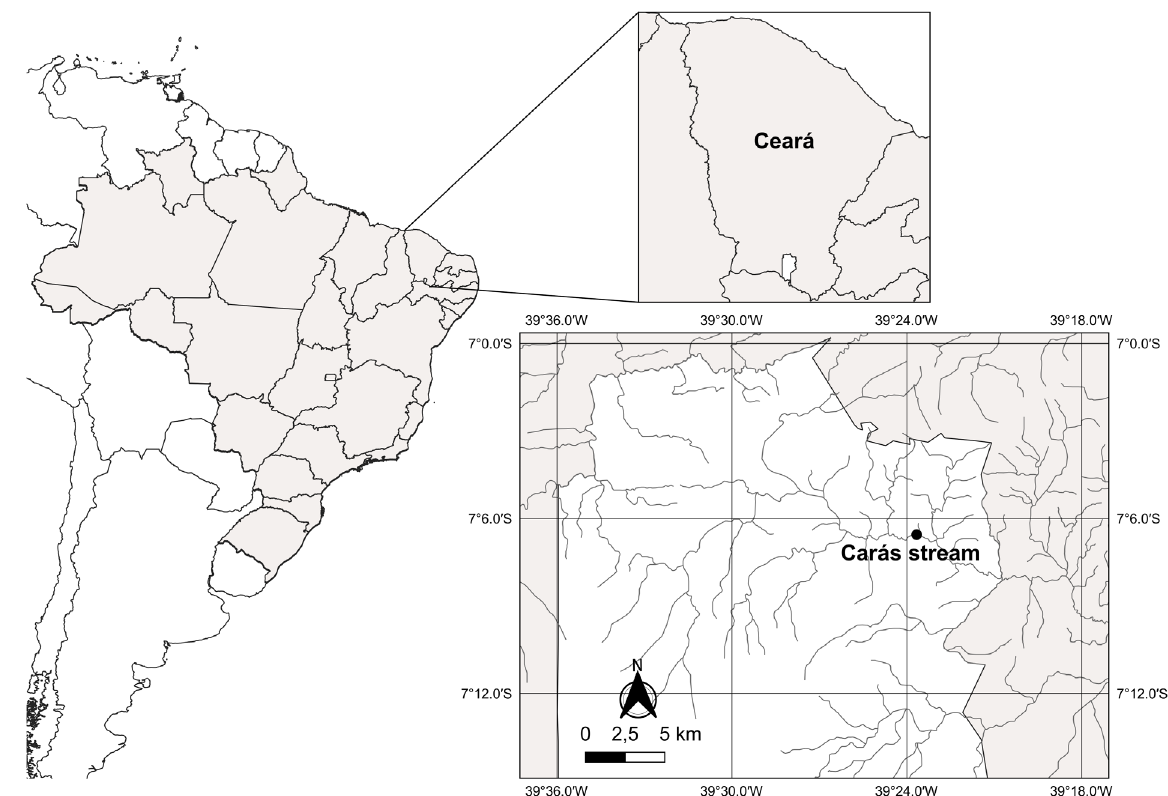
Figure 1. Sampling area, Carás stream, municipality of Crato, Ceará,